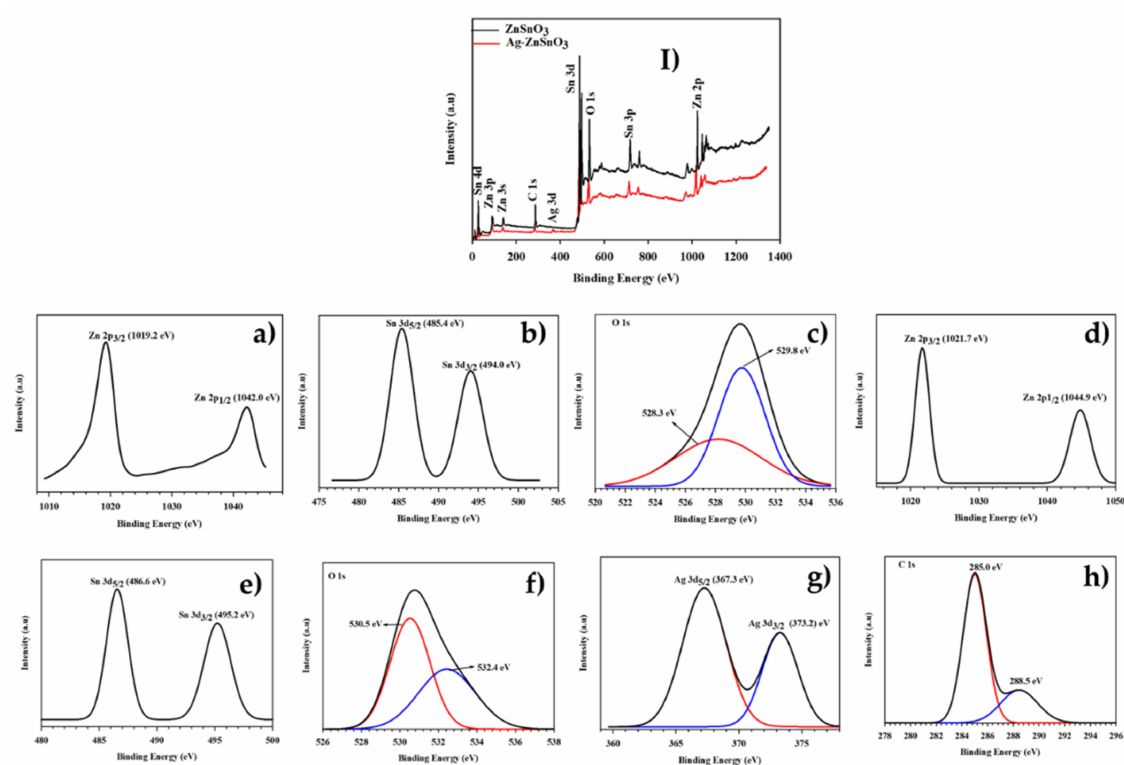
Figure 4. ( I ) XPS survey spectrum of ZnSnO 3 and Ag-ZnSnO 3 , and deconvoluted spectra of ( a ) Zn 2p, ( b ) Sn 3d, and ( c ) O 1s in ZnSnO 3 , and deconvoluted spectra of ( d ) Zn 2p, ( e ) Sn 3d, ( f ) O 1s, and ( g ) Ag 3d in Ag-ZnSnO 3 , and ( h ) C 1s spectra of both